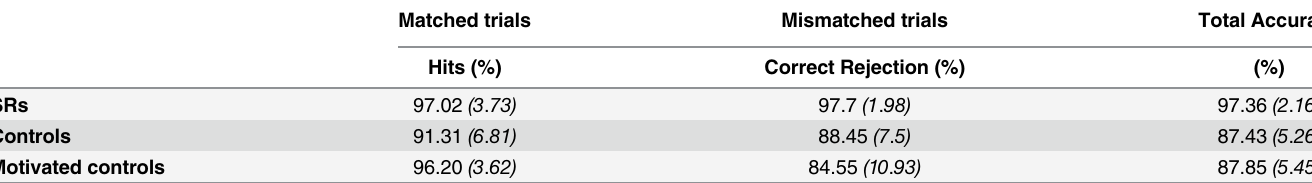
Table 2. Group accuracy descriptive statistics in GFMT. Standard deviations are in